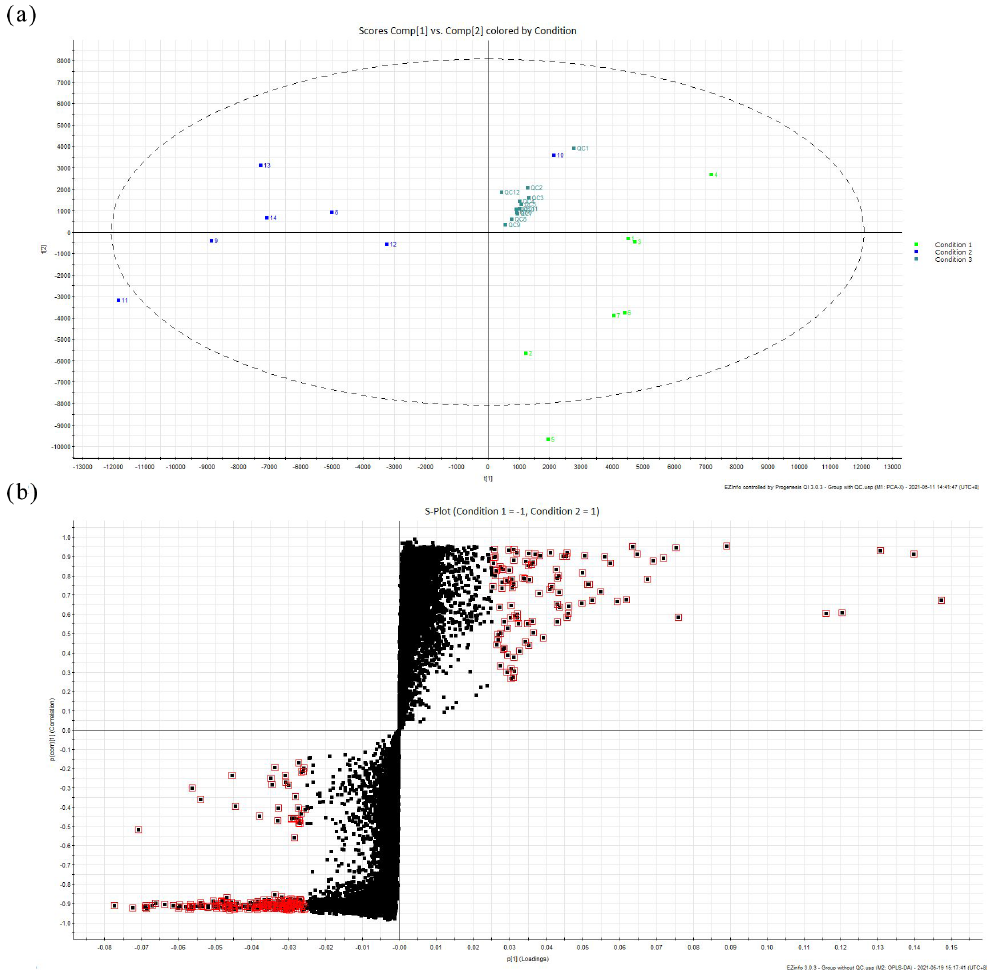
Figure 10. Multivariate analysis of the curtain: ( a ) PCA score plot; ( b ) S-Plot by the OPLS-DA model. A certain difference could be found between no. 10, with visible dirt, and the other unfaded areas. A series of ion peaks with molecular weight differences of 44 belonged to a -CH 2 CH 2 O- ethoxylate unit, meanwhile fragment ions m/z 133.08, 177.11, 221.13,